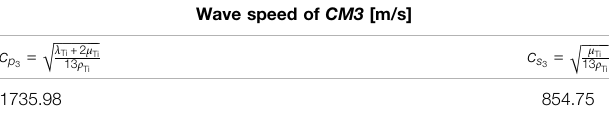
TABLE 7 | Wave speed expressions for the Cauchy material CM3 .